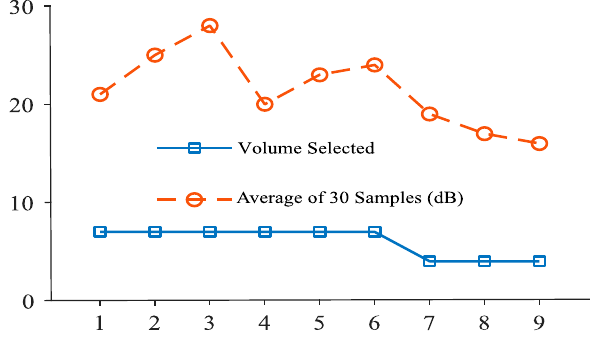
Figure 10. Volume selection for 30-decibel-level inputs.